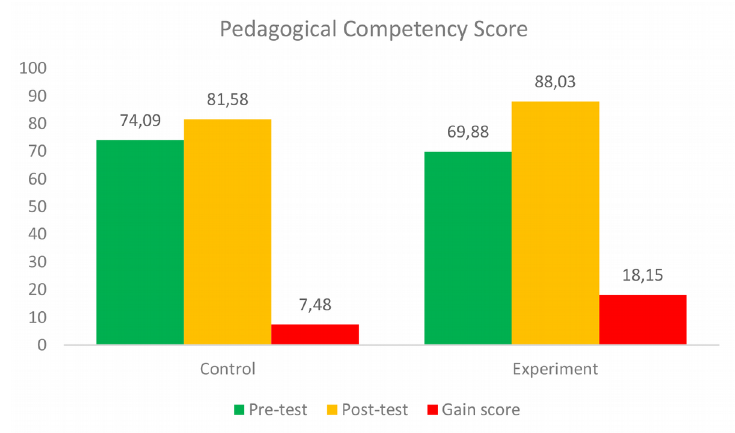
Figure 4. The Mean Gain Score for Pedagogical